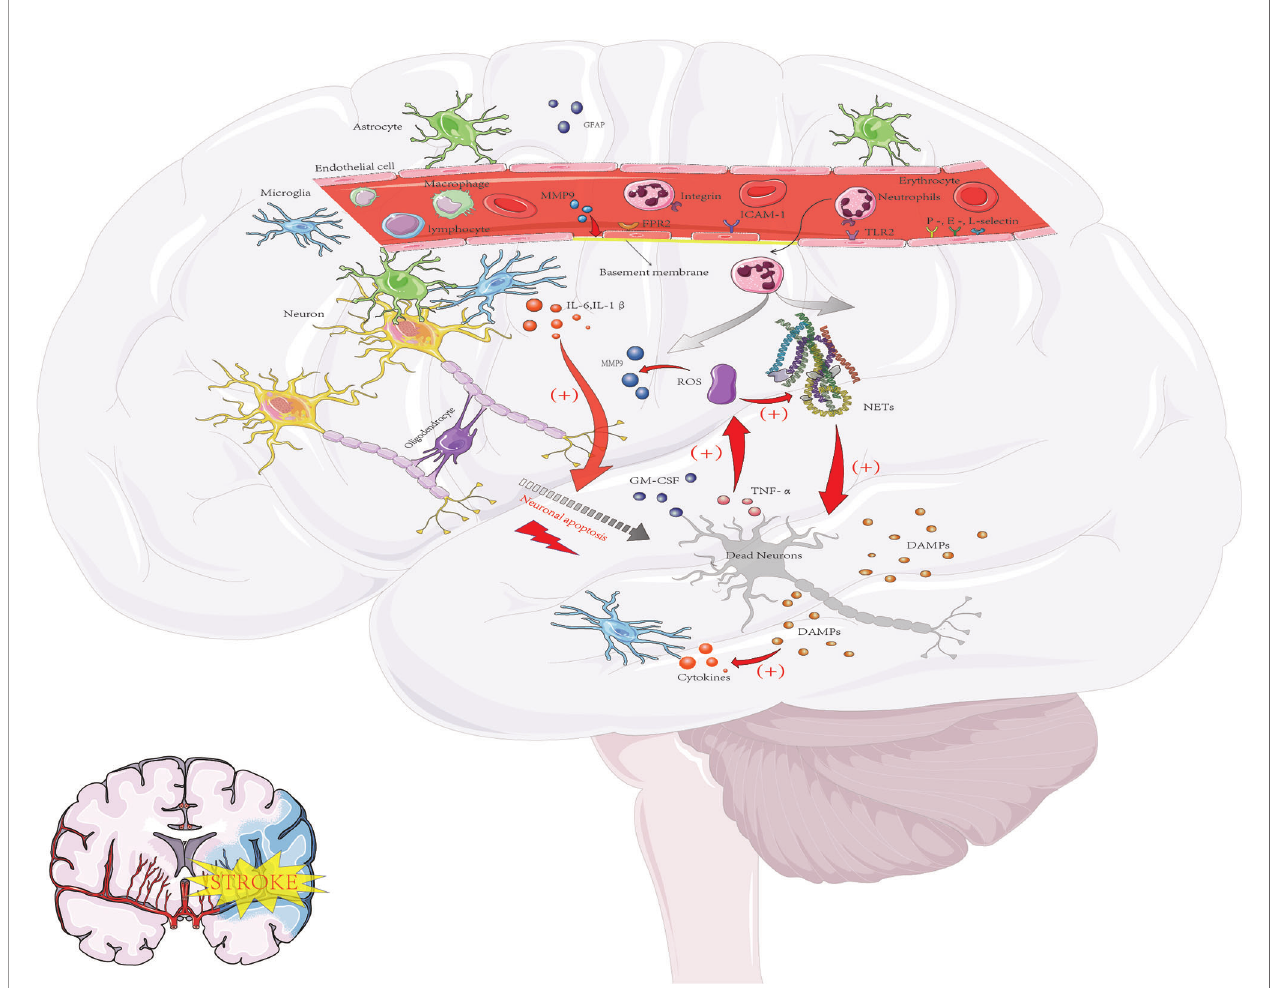
FIGURE 1 | The in fl ammatory response after cerebral ischemia. Acute ischemic events lead to oxidative stress and excitotoxicity, which lead to the activation of microglia and astrocytes and then promote the secretion of cytokines, MMPs and GFAP(glial fi brillary acidic protein). These proin fl ammatory signaling molecules lead to upregulation of the expression of ICAM-1 and selectins on endothelial cells and promote the entry of neutrophils, macrophages, lymphocytes and other blood- derived in fl ammatory cells into the ischemic area. Neutrophils are the fi rst group of leukocytes to enter the CNS. At in fl ammatory sites, high levels of proin fl ammatory cytokines such as GM-CSF and TNF- a can enhance the release of ROS. ROS can induce the production of MMP-9 through signaling pathways, which leads to tissue damage and excessive in fl ammatory responses, such as microvascular basement membrane damage and BBB damage, and then cause more peripheral neutrophils to enter the damaged area, aggravating the nerve injury response. The activation of neutrophils can also lead to the release of nuclear and particulate matter, which form a wide network of DNA complexes (NETs) that further aggravate neuronal damage. In addition, DAMPs, which in turn activate microglia and peripheral immune cells (neutrophils, macrophages and lymphocytes), are released by dying neurons, resulting in the production of proin fl ammatory factors and thus leading to further activation of neutrophils. These pathological events lead to neuronal death and further increase damage to the ischemic